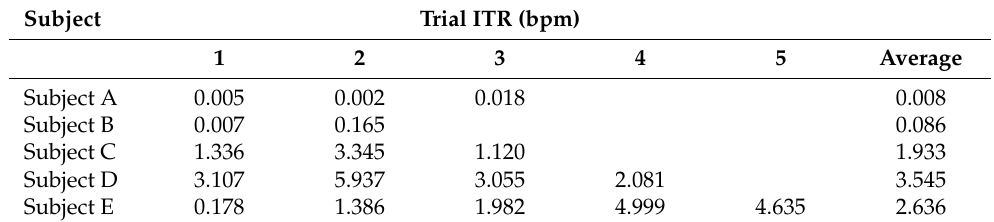
Table 5. ITR for every subject and trial.